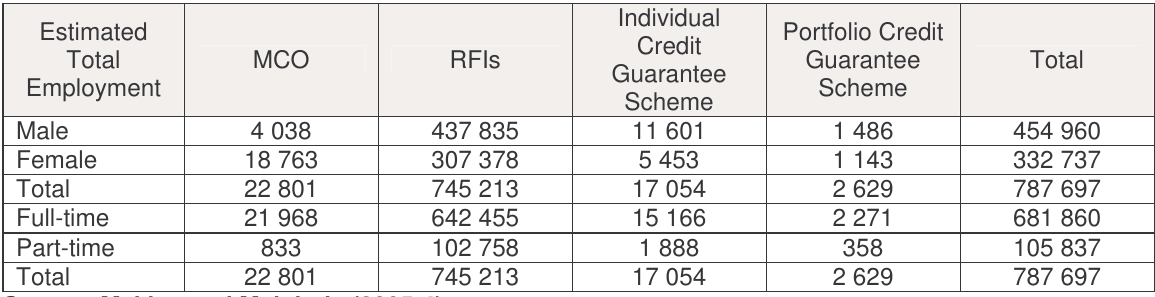
Table 2: Employment creation through Khula Enterprise Finance assistance programmes - 1996 to 2001 *